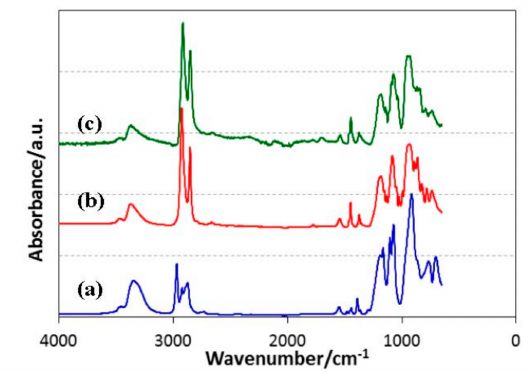
Figure 2. Synthetic route of ROSZs and the chemical structure of each alkyl in